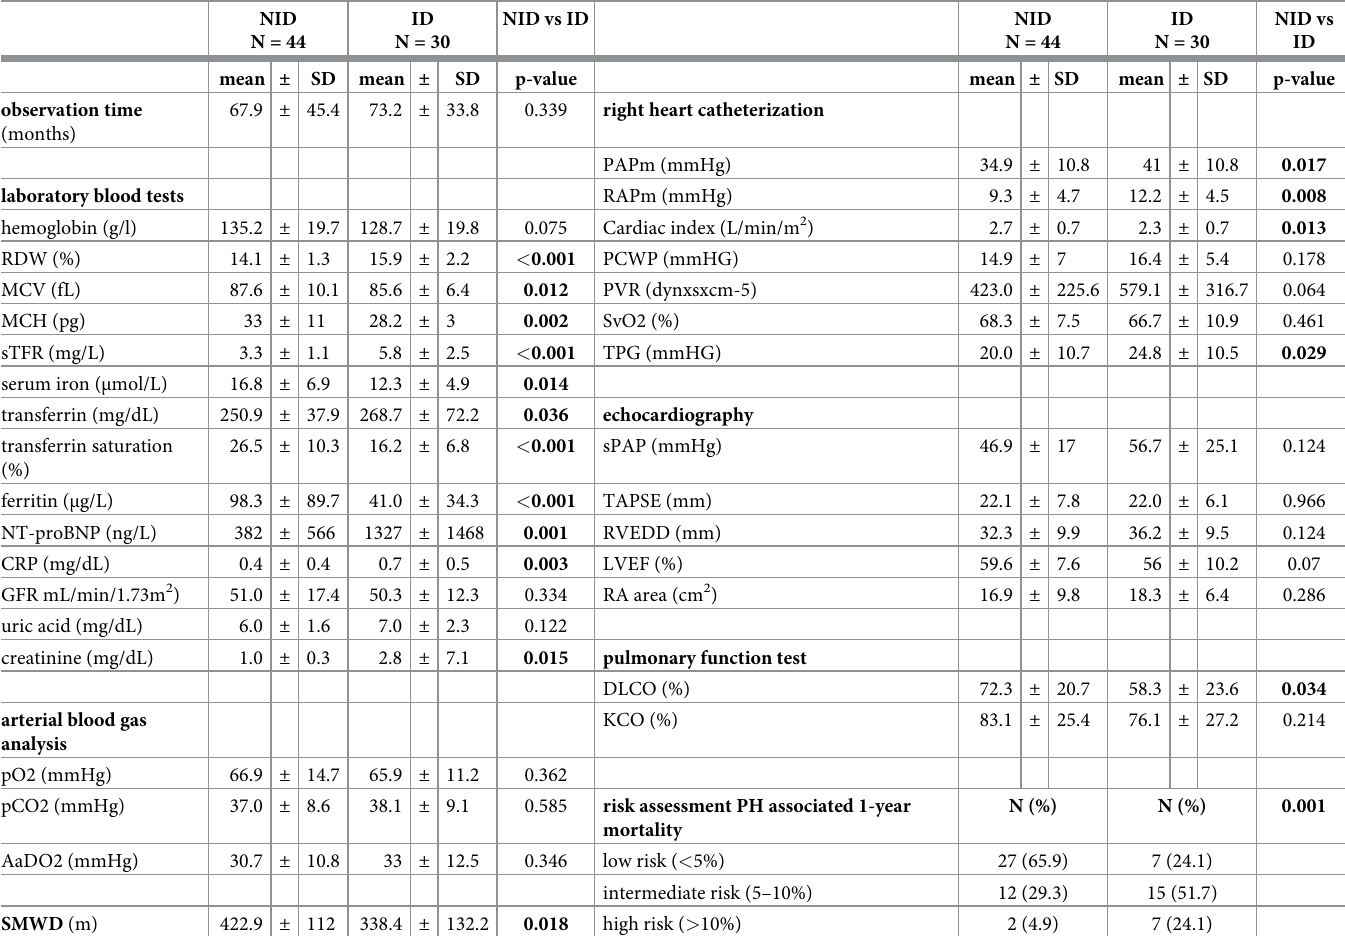
Table 2. Patients’ characteristics according to the sTFRF index at follow